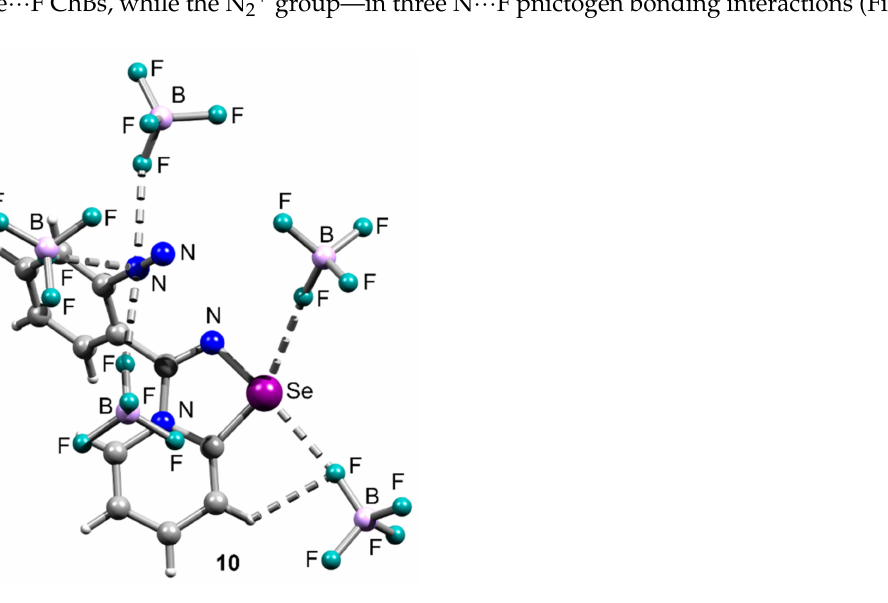
Figure 8. Ball-and-stick representation of the crystal structure of 10 , demonstrating attractive Se ··· F, H ··· F, and N ··· F interactions. Grey and light-grey spheres represent carbon and hydrogen,